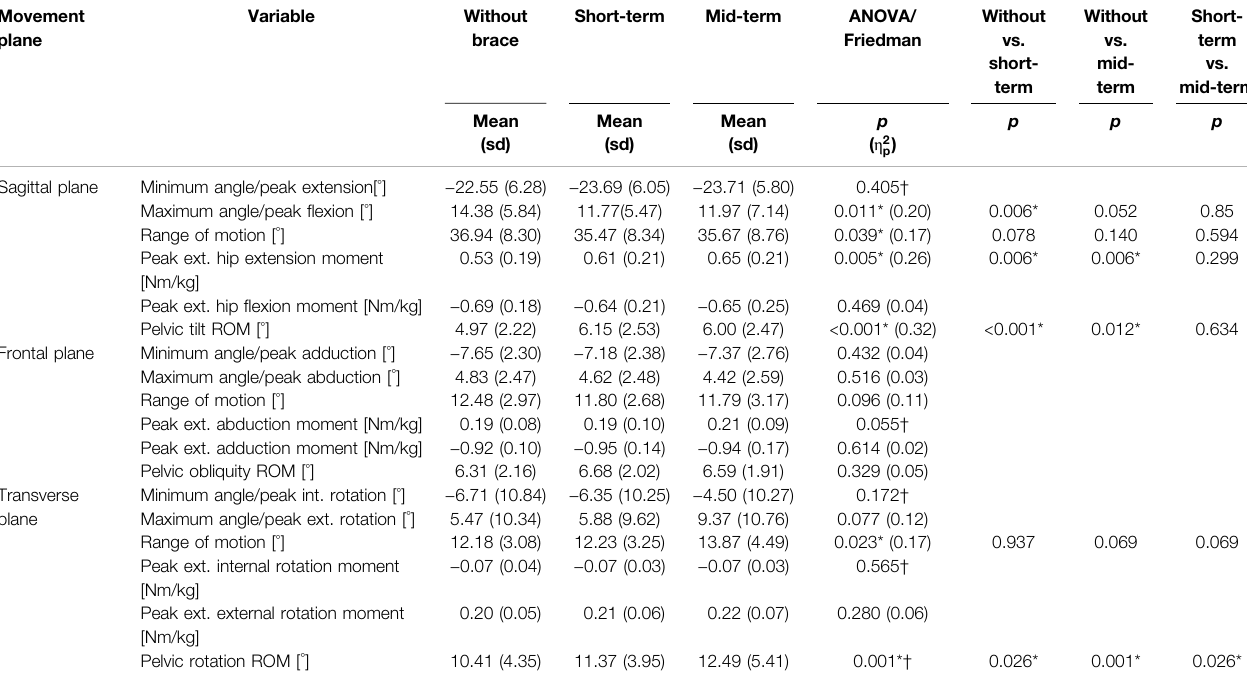
TABLE 5| Mean values and standard deviations (sd) ofdiscretejoint angle and jointmoment gait parameters for the HOA group with respective p-values and effectsizes as revealed by one-way repeated measures ANOVAs/Friedman tests and Holm-Bonferroni corrected pairwise comparisons. Level of signi fi cance ≤ 0.05; * marks a signi fi cant result; † marks analysis with a Friedman